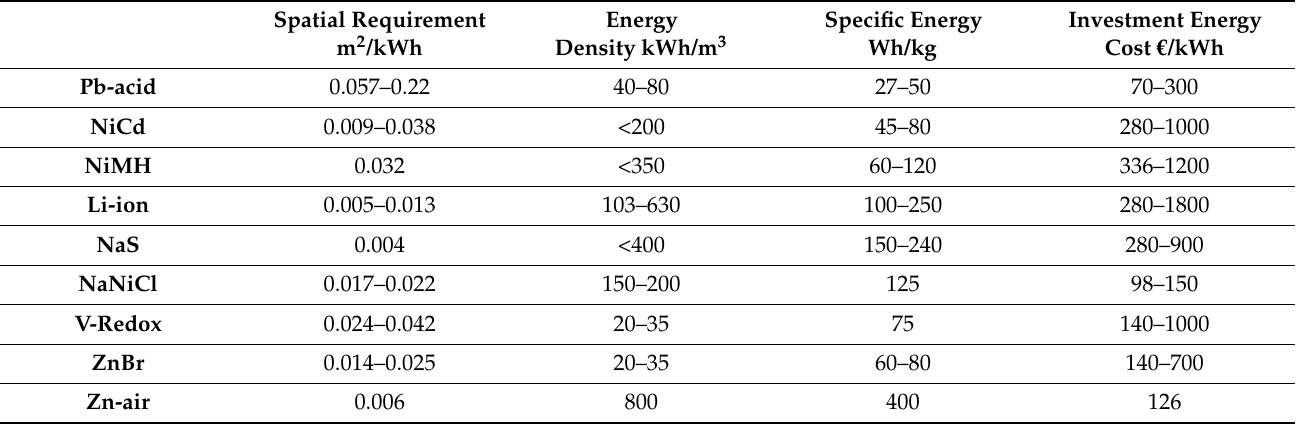
Table 3. Parameters and associated values to calculate spatial, mass and cost requirements (extracted from [35], investment cost values adjusted considering